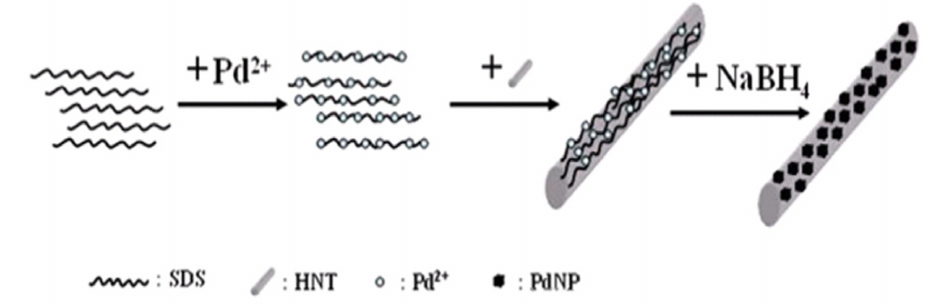
Figure 17: Schematic procedure of the synthesis of PdNPs-HNTs nanostructures demonstrated by Zheng et al. [157]